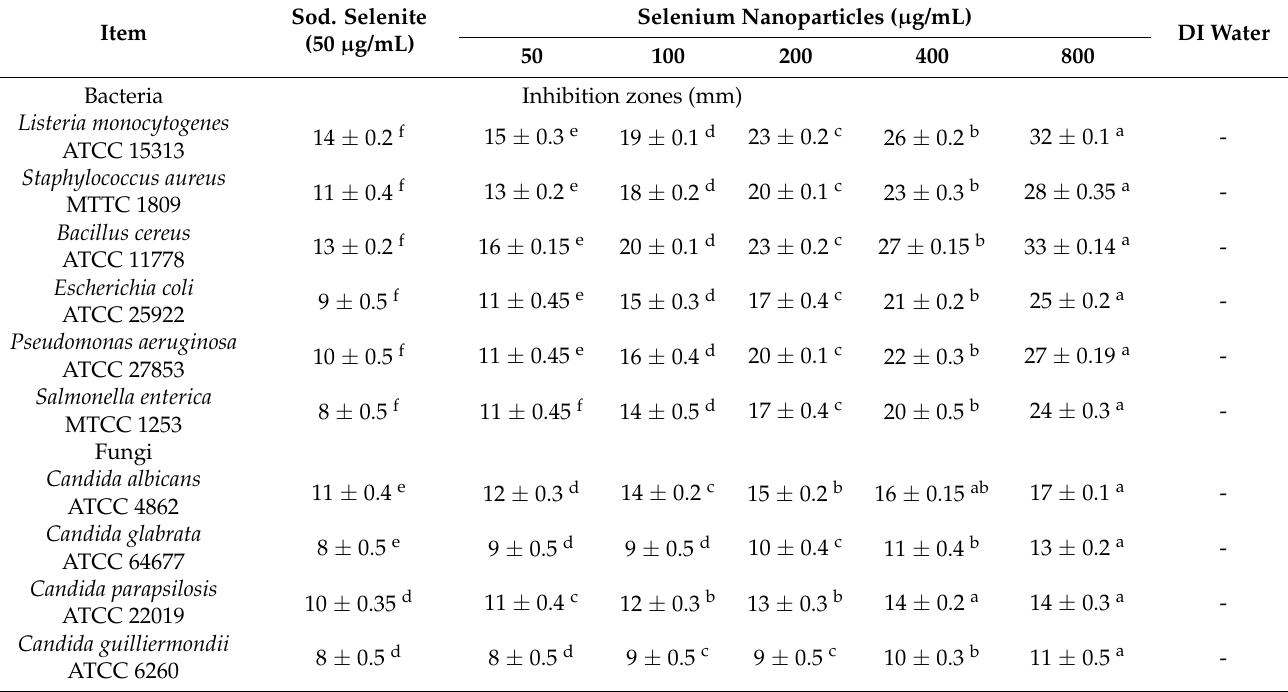
Table 2. Zone of inhibition produced by Sodium Selenite and selenium nanoparticles.